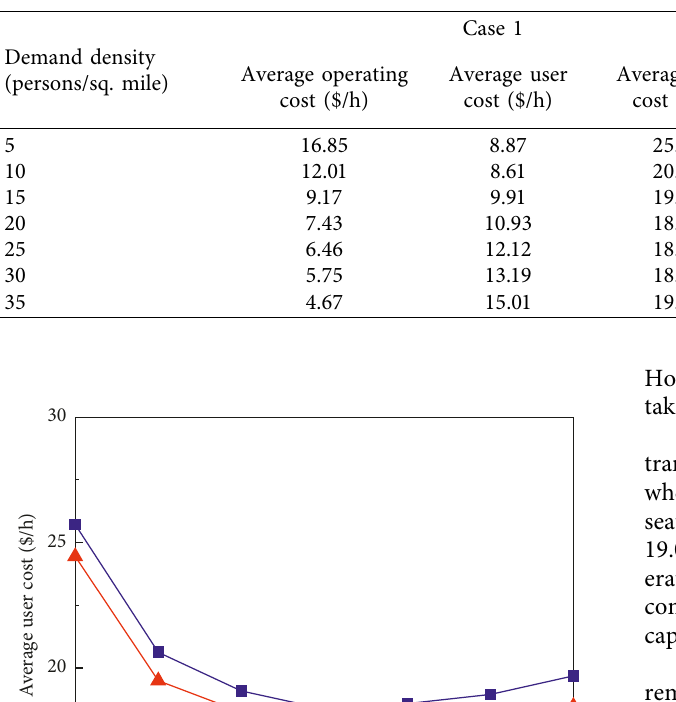
Table 4: Effects of demand density on costs.